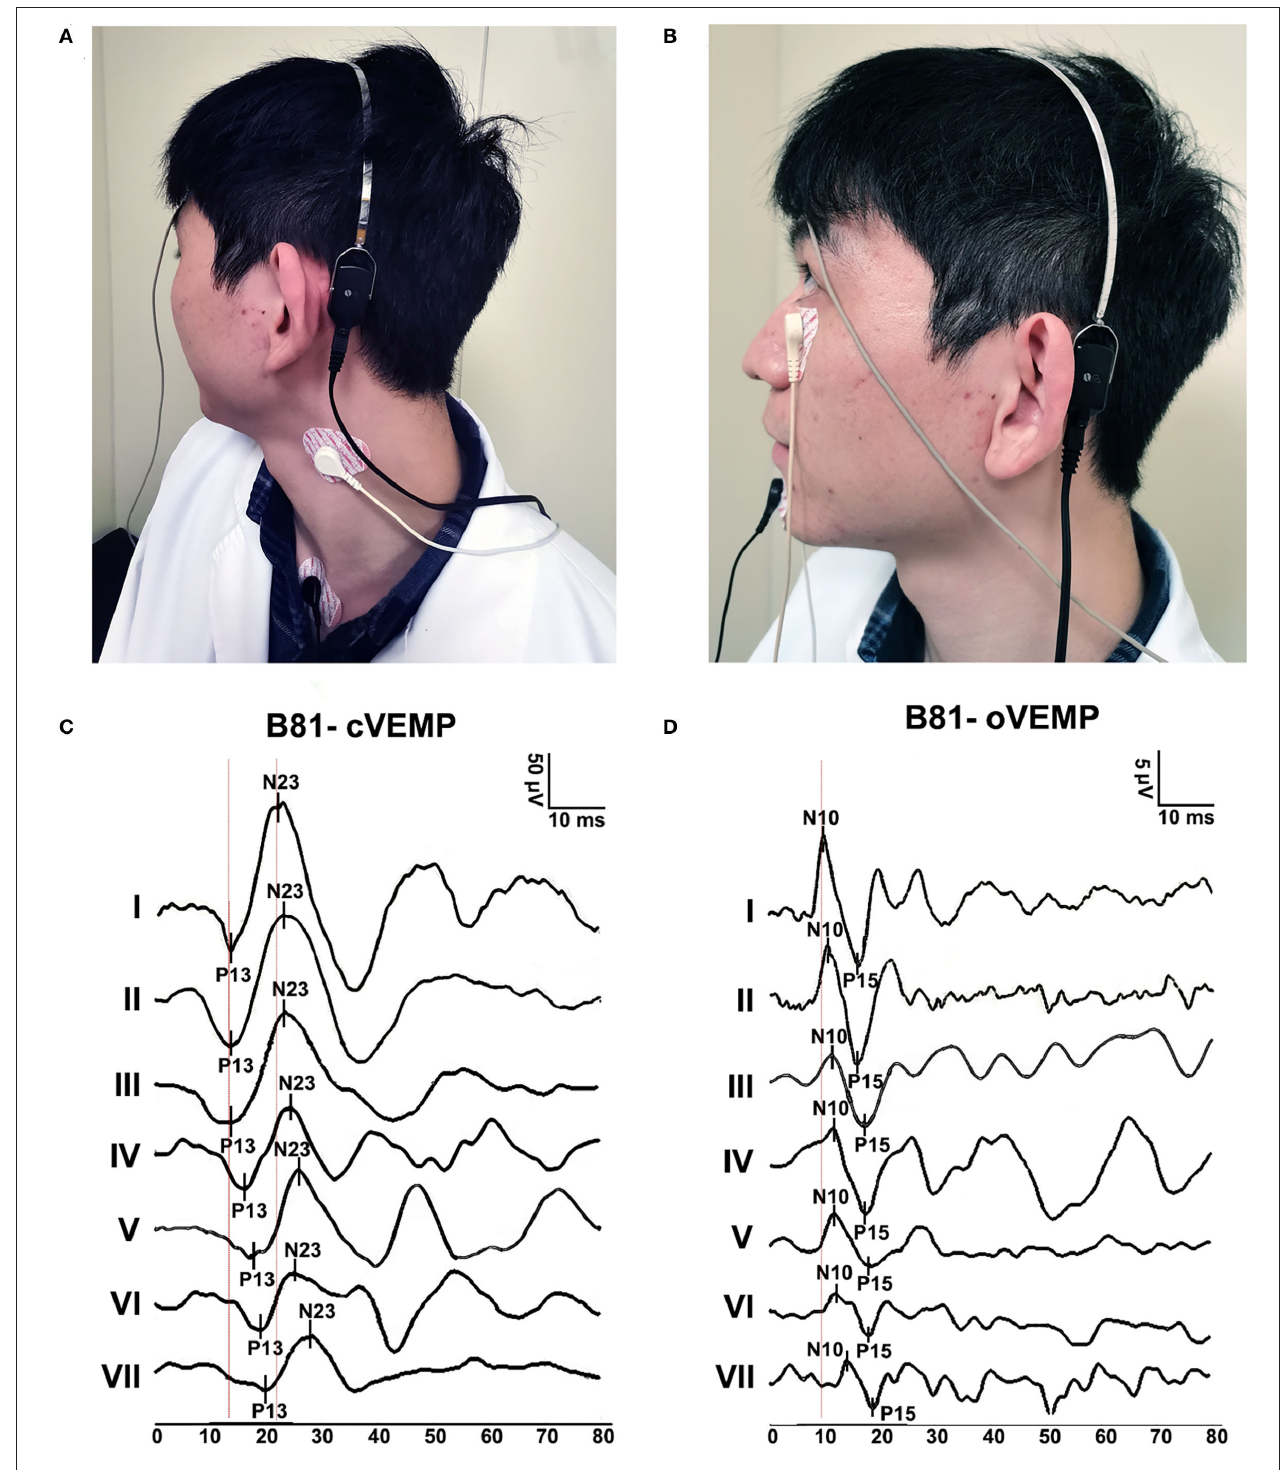
FIGURE 2 | B81-cVEMP and B81-oVEMP test positions and waveforms. (A) Testing position of B81-cVEMP. (B) The test position of B81-oVEMP. (C) Typical B81-cVEMP waveforms from I to VII age groups. The P13 and N23 latencies were prolonged, and the raw amplitude decreased with aging. (D) Typical B81-oVEMP waveforms from groups I to VII. The N10 latency of B81-oVEMP was prolonged with age.